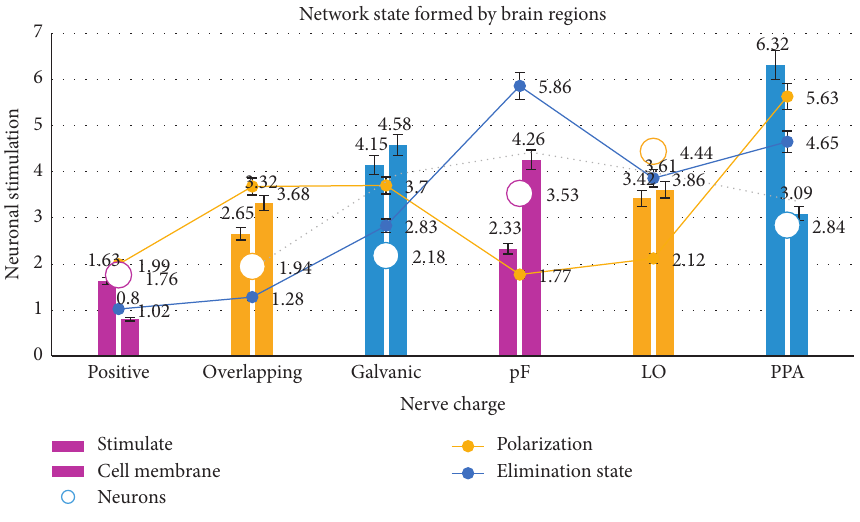
Figure 10: Network state formed by brain regions. Table 10: The effect of charge neuron stimulation on